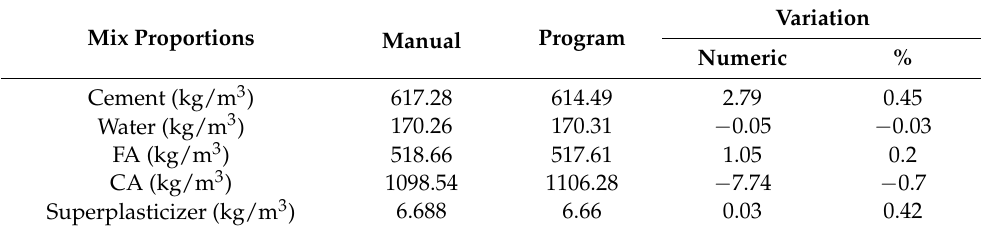
Table 3. A comparison between manual calculations and program outputs for modified DOE method